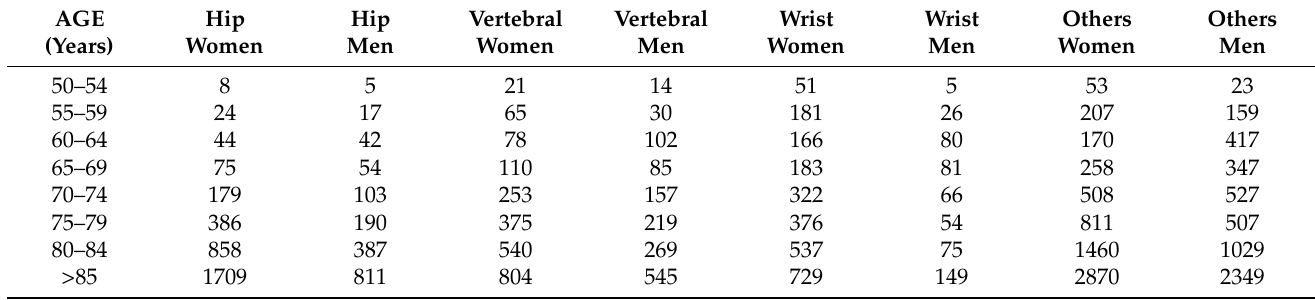
Table 1. Fracture incidence × 100,000 inhabitants/year in the Spanish population in 2010, adjusted according to INE.